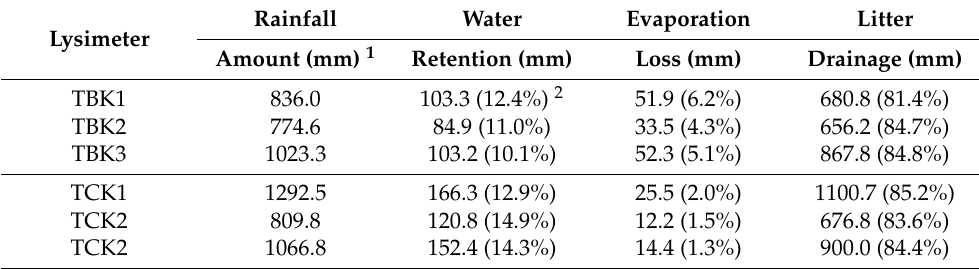
Table 4. Water balance analysis for rainfall periods.